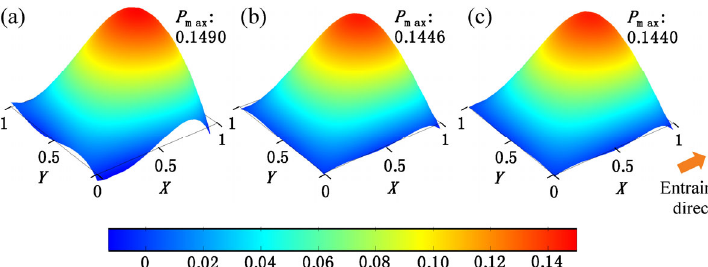
Fig. 7 Pressure distributions with different layer numbers ( N L ). (a) N L = 2, (b) N L = 3, (c) N L = 4.